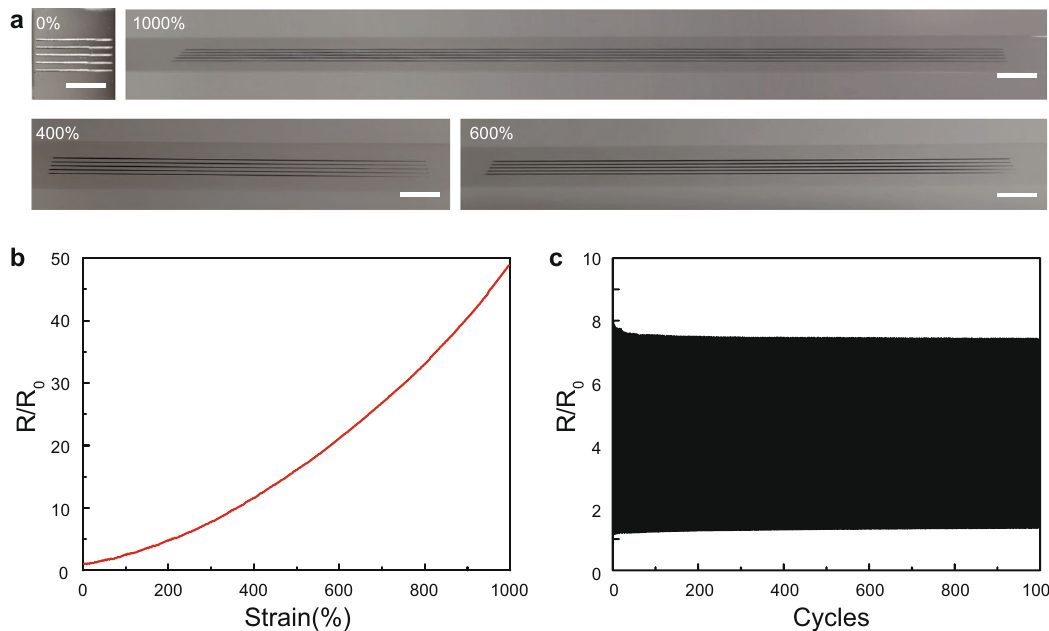
Fig. 3 Electromechanical properties of liquid metal features. a Optical images of a patterned liquid metal feature at pristine and uniaxially stretched states up to 1000% strain. Scale bar: 1 cm. b Normalized resistance as a function of tensile strain. c Evolution of normalized resistance during 1000 stretch-relaxation cycles to 300% strain.